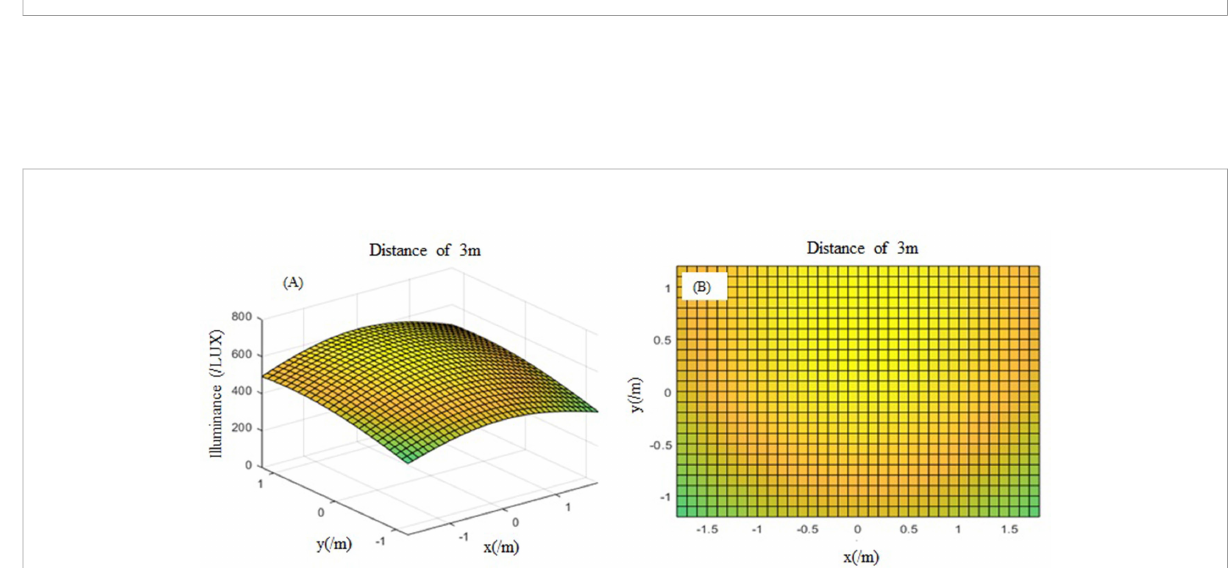
FIGURE 5 The illumination distribution of whole lighting system with a lighting distance of 3m. (A) the 3D view of illumination distribution; (B) the vertical view of illumination distribution.